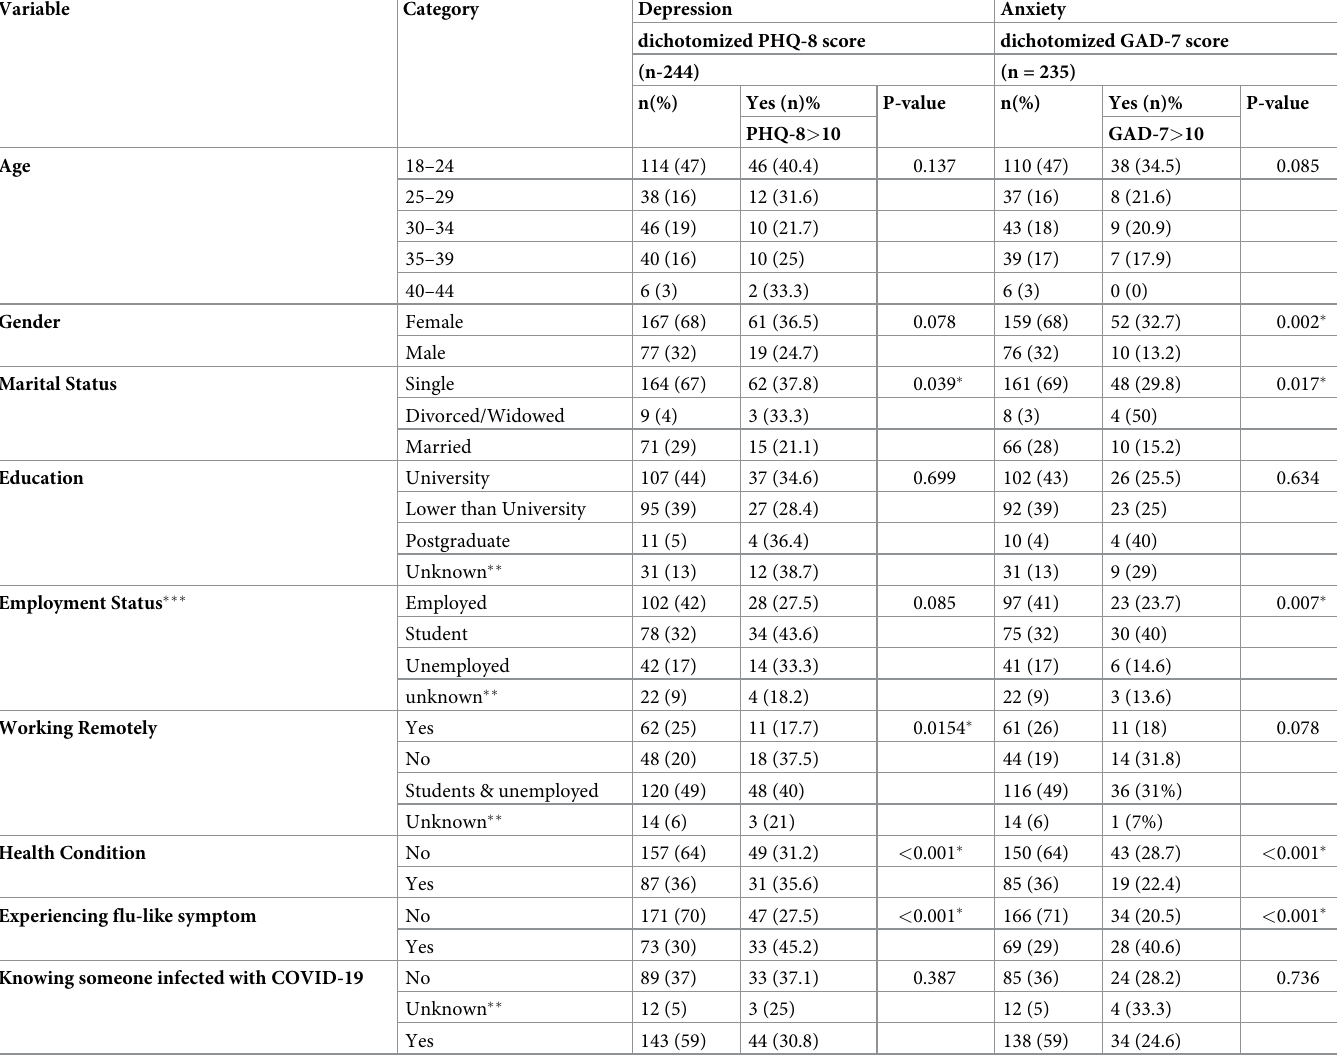
Table 1. Demographic characteristics by the dichotomized PHQ-8 score (PHQ-8 > 10) and dichotomized anxiety score (GAD-7 > 10) during the